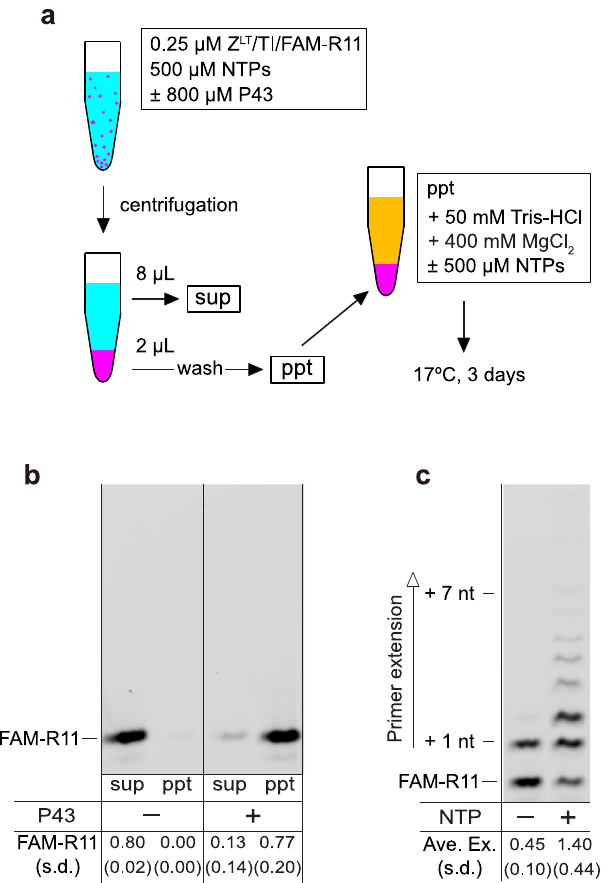
Fig. 5 Reactivation of the captured RPR in high MgCl 2 conditions. a Schematic depiction of the experimental procedure. b The fl uorescently- labeled primer contained in the supernatant and precipitate samples. The amount of FAM-R11 in the supernatant without P43 was normalized as 0.80, by assuming that 80% of the RNA from the 10 µ L sample was recovered in the 8 µ L supernatant. c Co-precipitation of RPR and P43, incubated in 50 mM Tris • HCl (pH 8.3) buffer containing 400 mM MgCl 2 , ± 500 µ M of each NTP at 17 °C for 3 days. b , c Mean values and S.D. are presented below the gel images ( N =